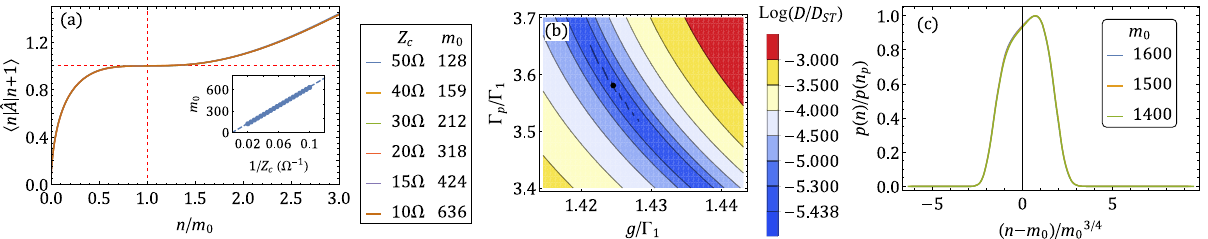
Fig. 4 The Approximately Bare Operator Coupling Circuit (ABOCC) operator and the linewidth and photon distribution of the ABOCC laser. a The j n þ 1 i as a function of the photon number in the cavity shows a plateau on which the matrix element is independent of the photon matrix element h n j ^ A c ; m 0 number thus approximating the bare operator. The matrix elements, which we computed for cavity impedance Z c = 50 Ω (blue), 40 Ω (orange), 30 Ω (green), 20 Ω (salmon), 15 Ω (purple), and 10 Ω (brown) which controls m 0 as shown in the inset (the impedance of the qubit was set to Z a = 47.71 Ω ), appear almost indistinguishable after re-scaling the photon number by m 0 . b Tuning the ABOCC laser by varying the pump power Γ p and the atom-cavity coupling strength g that is controlled by I J:a-c . c The photon number distributions of the optimum linewidth point at m 0 = 1600 (blue), 1500 (orange), and 1400 (green). All three lines appear to collapse after appropriate re-scaling of